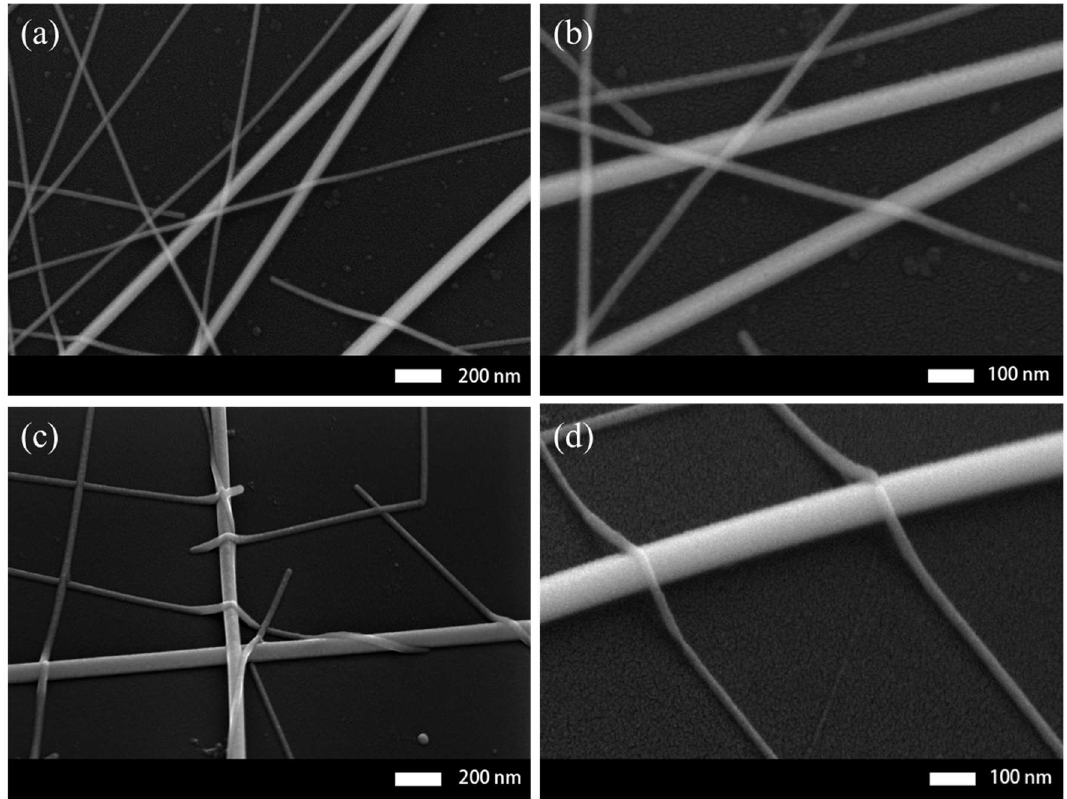
Figure 3. ( a ) Low-and ( b ) high-magnification scanning electron microscope (SEM) images of the Figure 3. ( a ) Low‐and ( b ) high‐magnification scanning electron microscope (SEM) images of the SLD-AgNW network without welding. ( c ) Low- and ( d ) high-magnification SEM images of the welded SLD‐AgNW network without welding. ( c ) Low‐ and ( d ) high‐magnification SEM images of the SLD-AgNW welded SLD‐AgNW network.